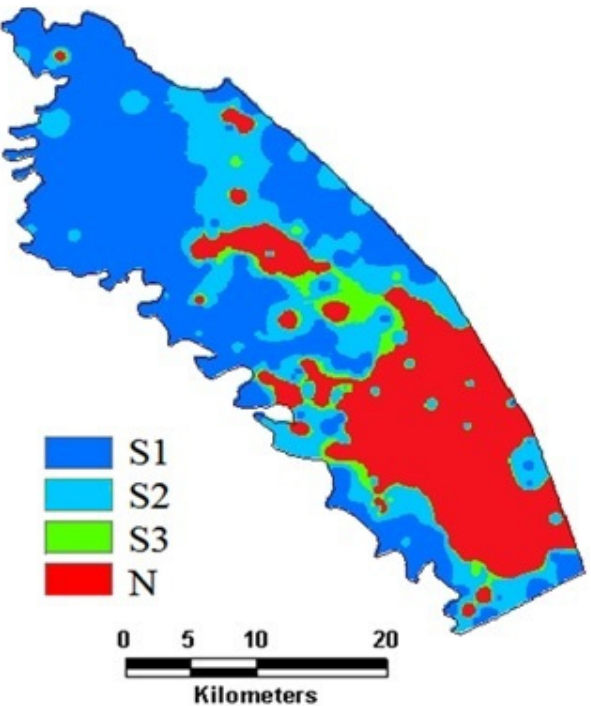
Figure 4. Land suitability map for barley using the fuzzy-AHP method (S1: high suitability, S2: moderate suitability, S3: marginal suitability, N: non-suitability).